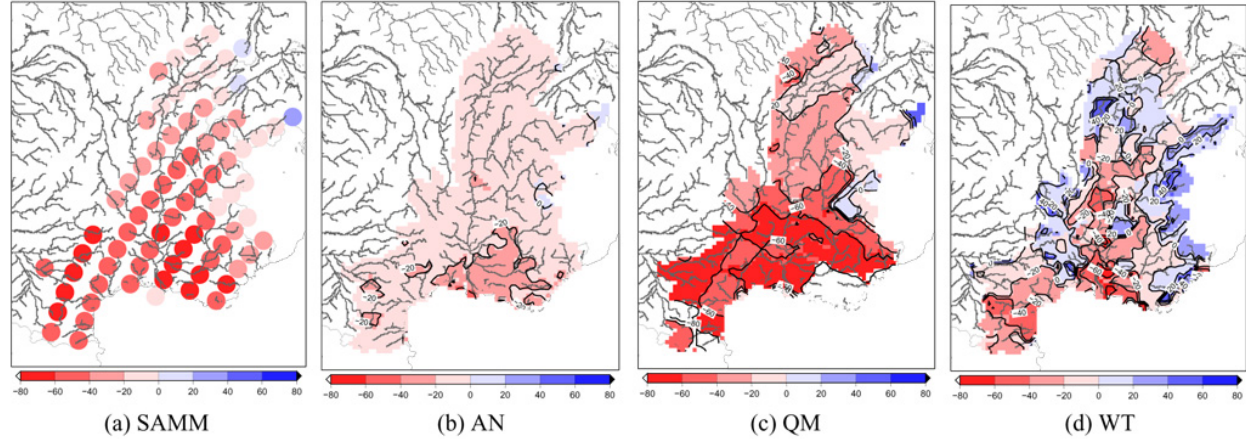
Fig. 7. Anomaly (2035–2064 vs. 1970–1999) of PDJJA (in %).